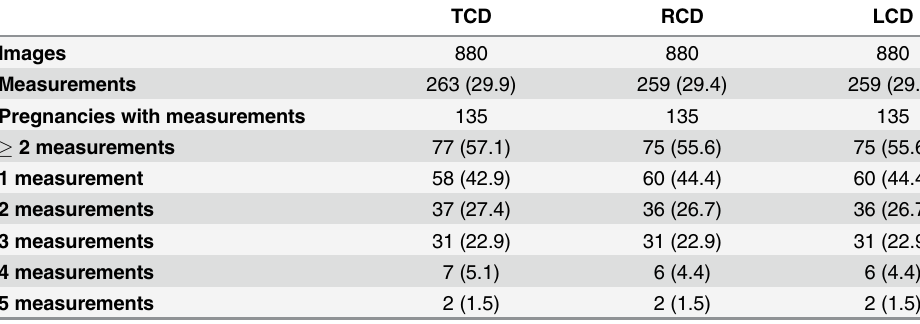
Table 2. 3D-Ultrasound data and the success rate of measurements.